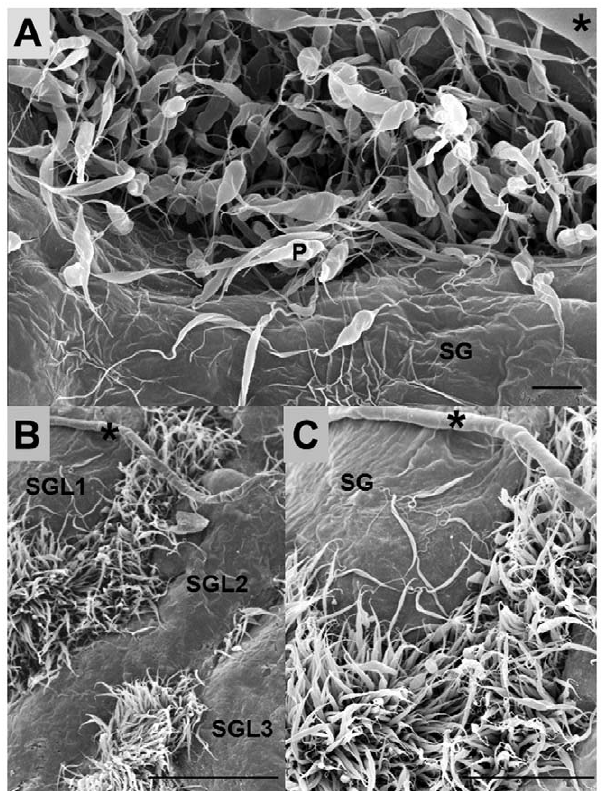
Figure 1. Scanning electron microscopy of invitro interaction between P.serpens and explanted O.fasciatus salivary glands. The salivary glands were explanted and incubated in the presence of a suspension of parasites. ( A ) Parasite adhesion to the salivary gland basal lamina occurs through the flagellum and the cell body. ( B ) Penetration of the parasites into the salivary gland started by the parasite cell body. ( C ) Several parasites are invading the same area of the basal lamina clearly through the cell body, as their flagella can be observed outside. ( D ) Parasites after penetration covered by basal lamina. The arrows indicate suggestive lesions in the basal lamina ( B – D ). Flagellum (F); parasite cell body (B). Scale bars: 5 m m.